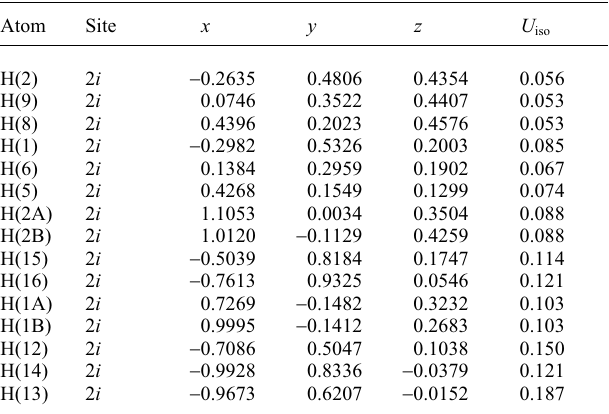
N–H --- N hydrogen bond (N1 --- N3: 2.595(3) Å, N1–H1 --- N3: 110°) form in the molecule. In total, all bond lengths in the mole- cules are within normal values [11]. Table 2. Atomic coordinates and displacement parameters (in Å 2 )